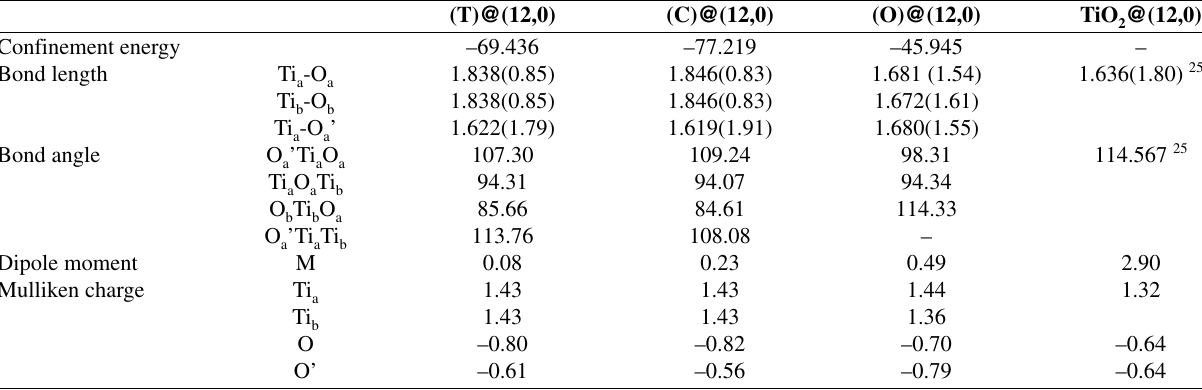
Table 2. Confinement energy (kcal mol –1 ), selected geometrical parameters (Bond length in Å and angles in degrees) and Mulliken atomic charge of TiO